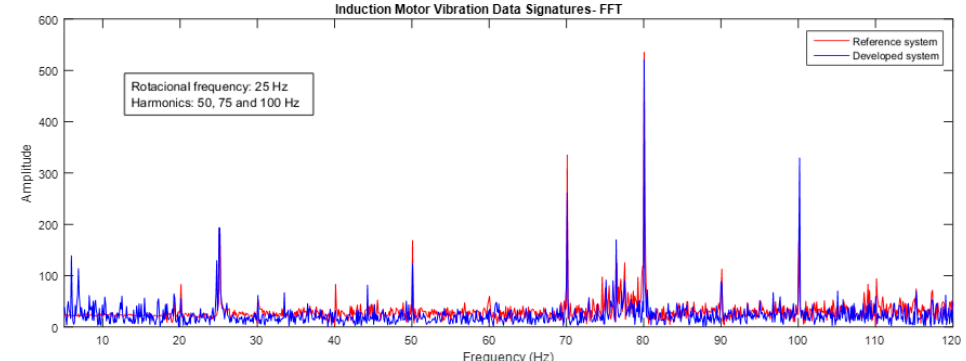
Figure 10. Comparison of vibration signatures obtained from the measurements performed on an induction motor at a rotation speed of 25 Hz.